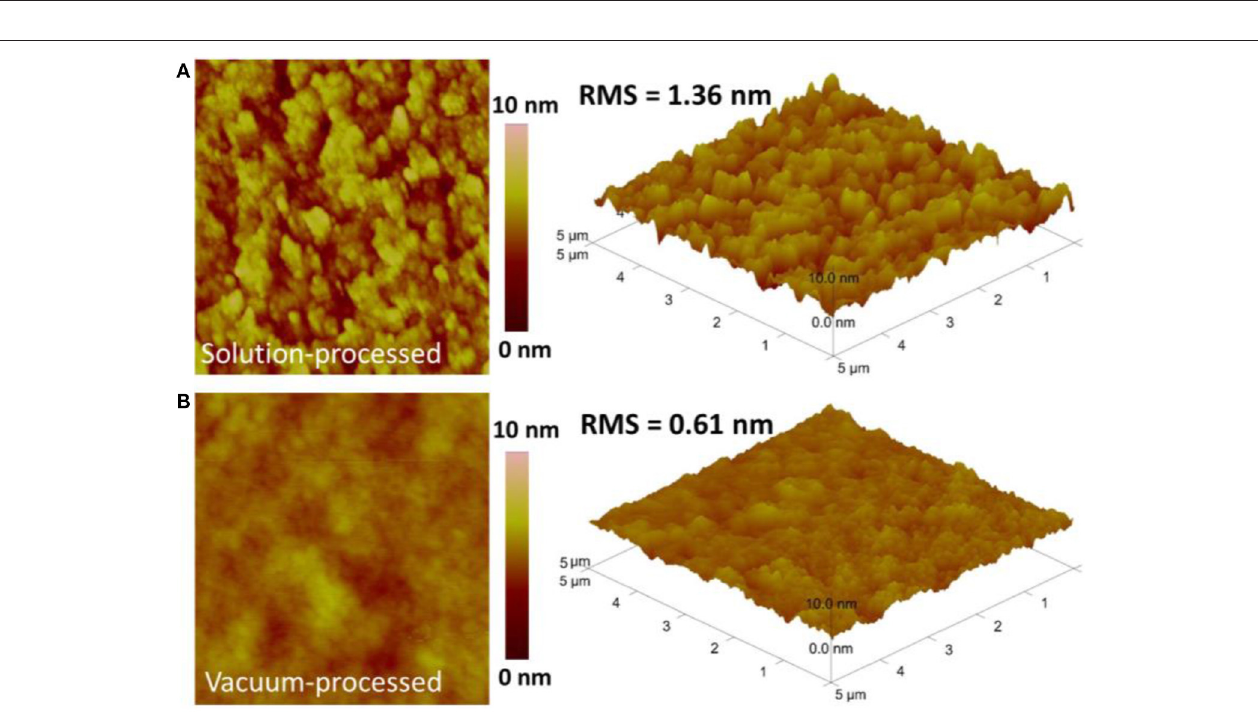
Frontiers in Chemistry |